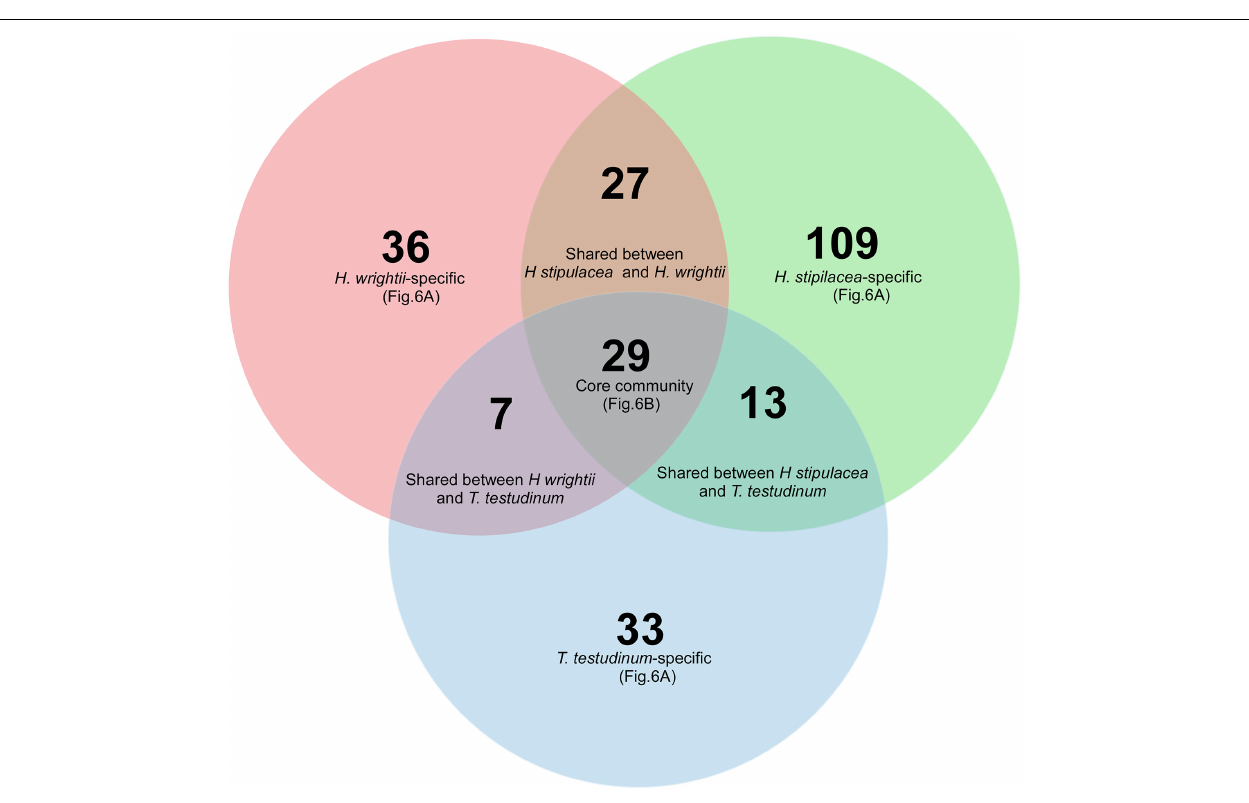
orders, respectively ( Figure 6A ). The three seagrasses shared